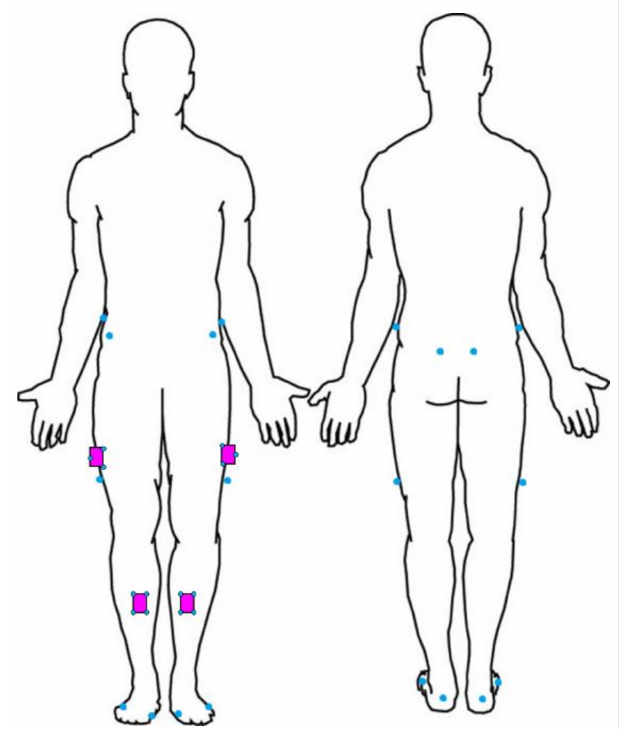
Figure 1. Placement of IMUs (purple) used for training the CNN models and Vicon marker (blue) placement for recording start and end times for each